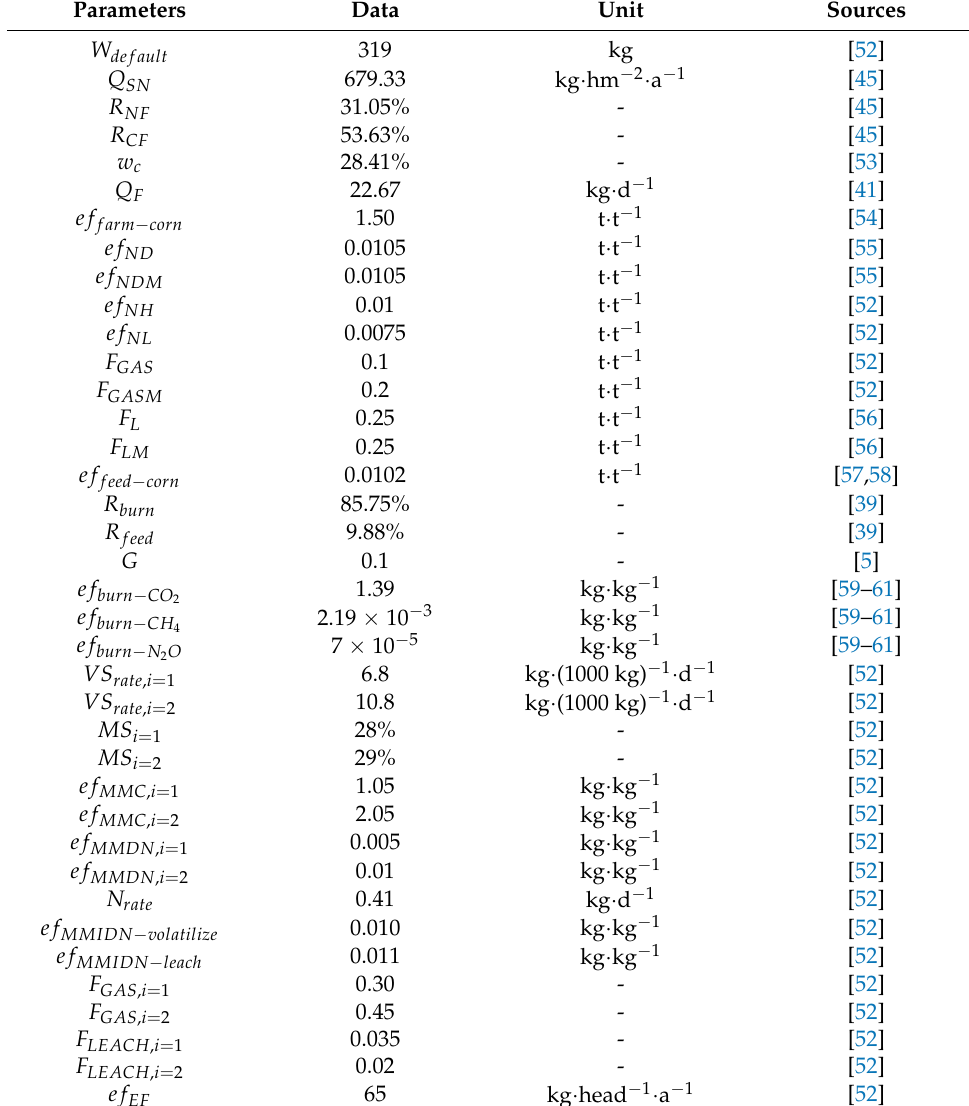
Table 1. List of parameters for estimating GHG emissions for the livestock and arable farming system.